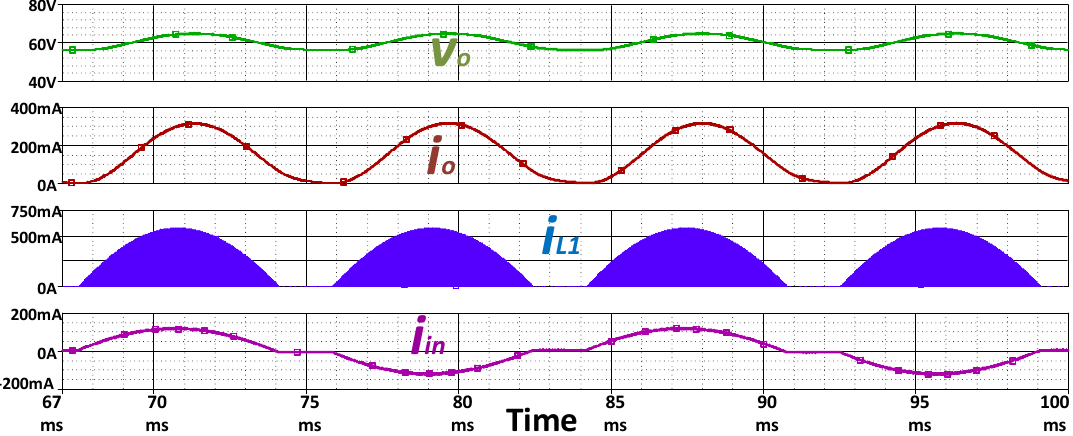
Figure 13. Waveforms resulting from the simulation in Spice. Output voltage ( v o ), output current ( i o ), current of the primary side ( i L1 ), and input current ( i in ).